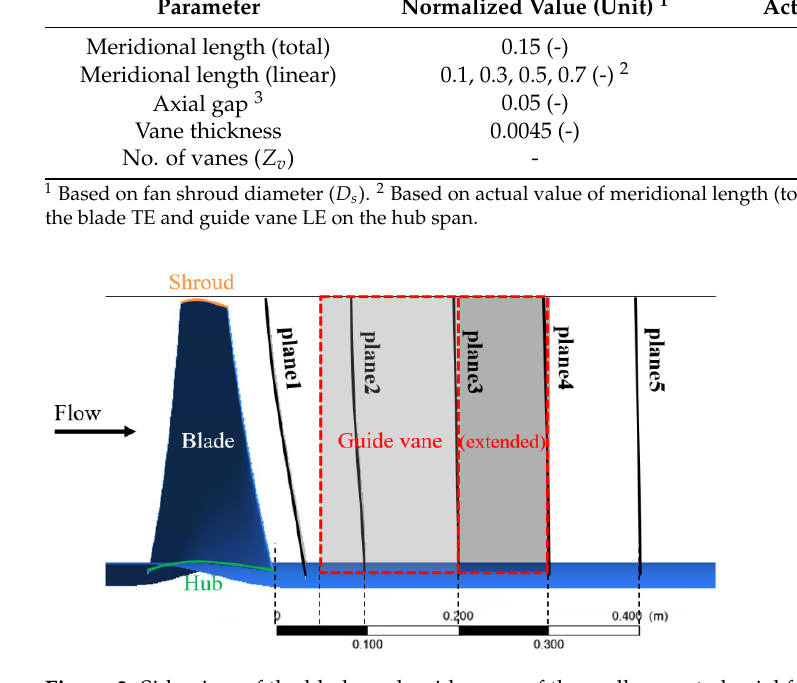
Figure 3. Side view of the blade and guide vane of the wall-mounted axial fan.